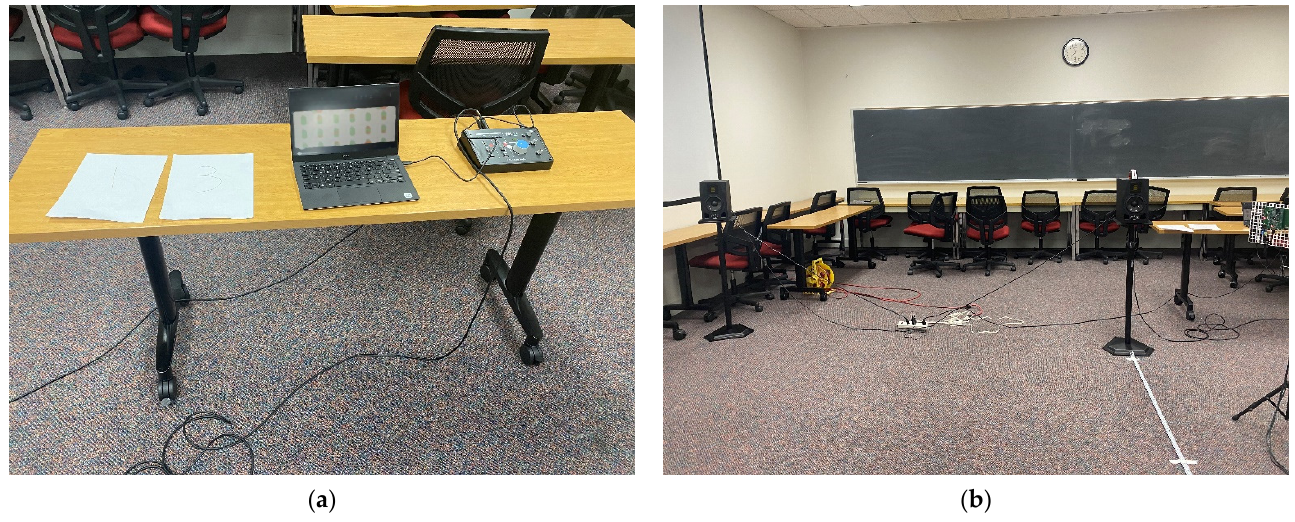
Figure 16. Actual transmitter device realization: ( a ) Computer and USB audio interface; ( b ) Two speakers with 3 m apart.